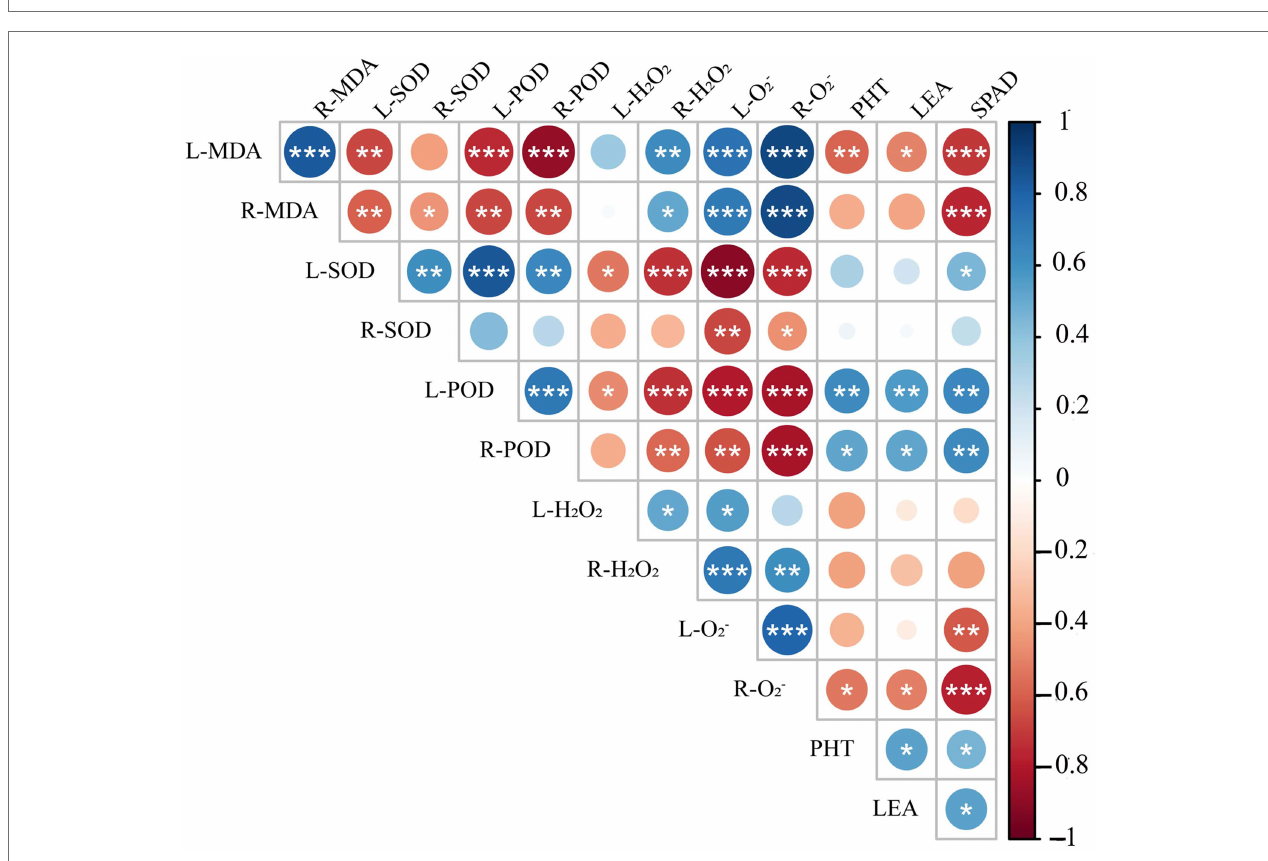
FIGURE 11 | Correlation analysis of 13 indexes between morphological and physiological indicators in triticale seedlings. L-MDA, leaf malondialdehyde content; R-MDA, roots malondialdehyde content; L-SOD, leaves superoxide dismutase activity; R-SOD, roots superoxide dismutase activity; L-POD, leaves peroxidase activity; R-POD, roots peroxidase activity; L-H 2 O 2 , leaves hydrogen peroxide activity; R-H 2 O 2 , roots hydrogen peroxide activity; L-O 2 − , leaves superoxide anion activity; R-O 2 − , roots superoxide anion activity; PHT, plant height; LEA, leaf area; SPAD, relative chlorophyll content. The asterisk indicates significant difference. * p < 0.05; ** p < 0.01; *** p <